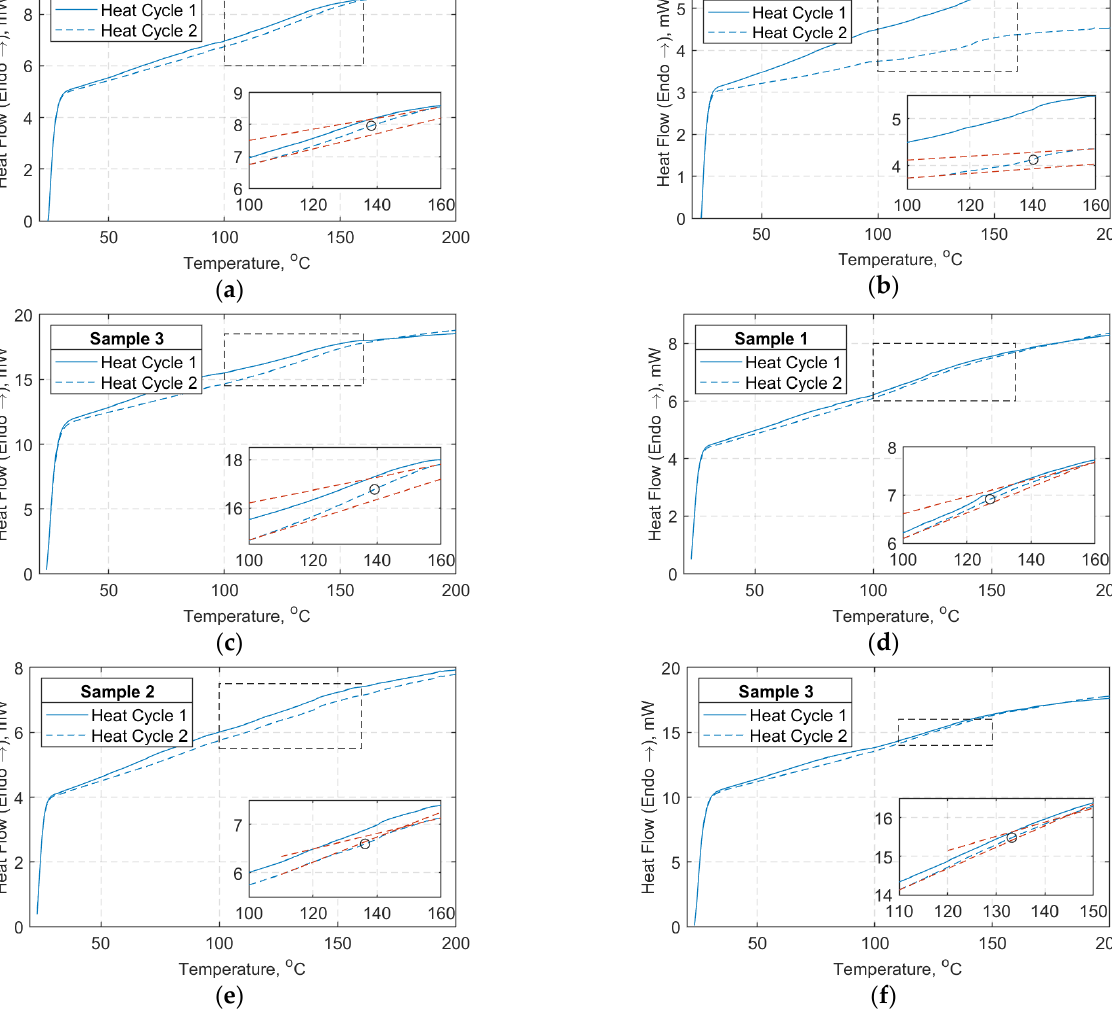
Figure A1. DSC plots (heat flow, mW vs. temperature, °C) for composite material of the straps: ( a – c ) are the samples extracted from the middle shaft length of the straps, while ( d – f ) are the samples from the curvature region of the